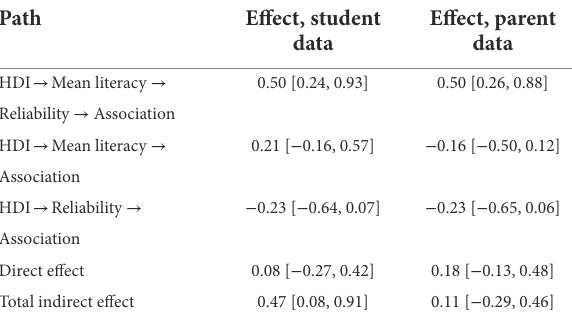
TABLE 2 Results of sequential mediation analysis of the effect of HDI on the strength of the association between students’ literacy scores and estimates of their number of books at home.